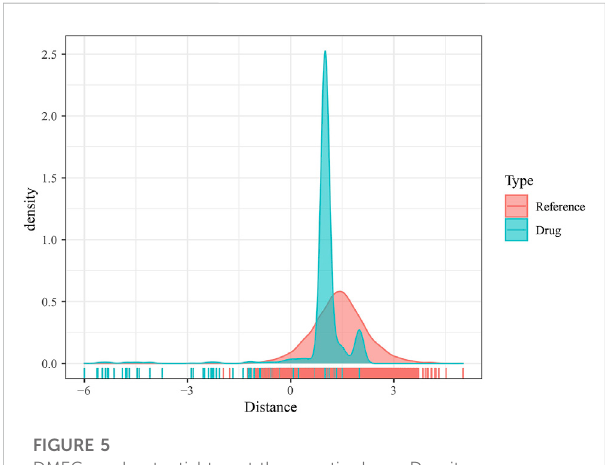
FIGURE 5 DMEGs and potential target therapeutic drugs. Density fractionation plot of drug to DMEGs gene set